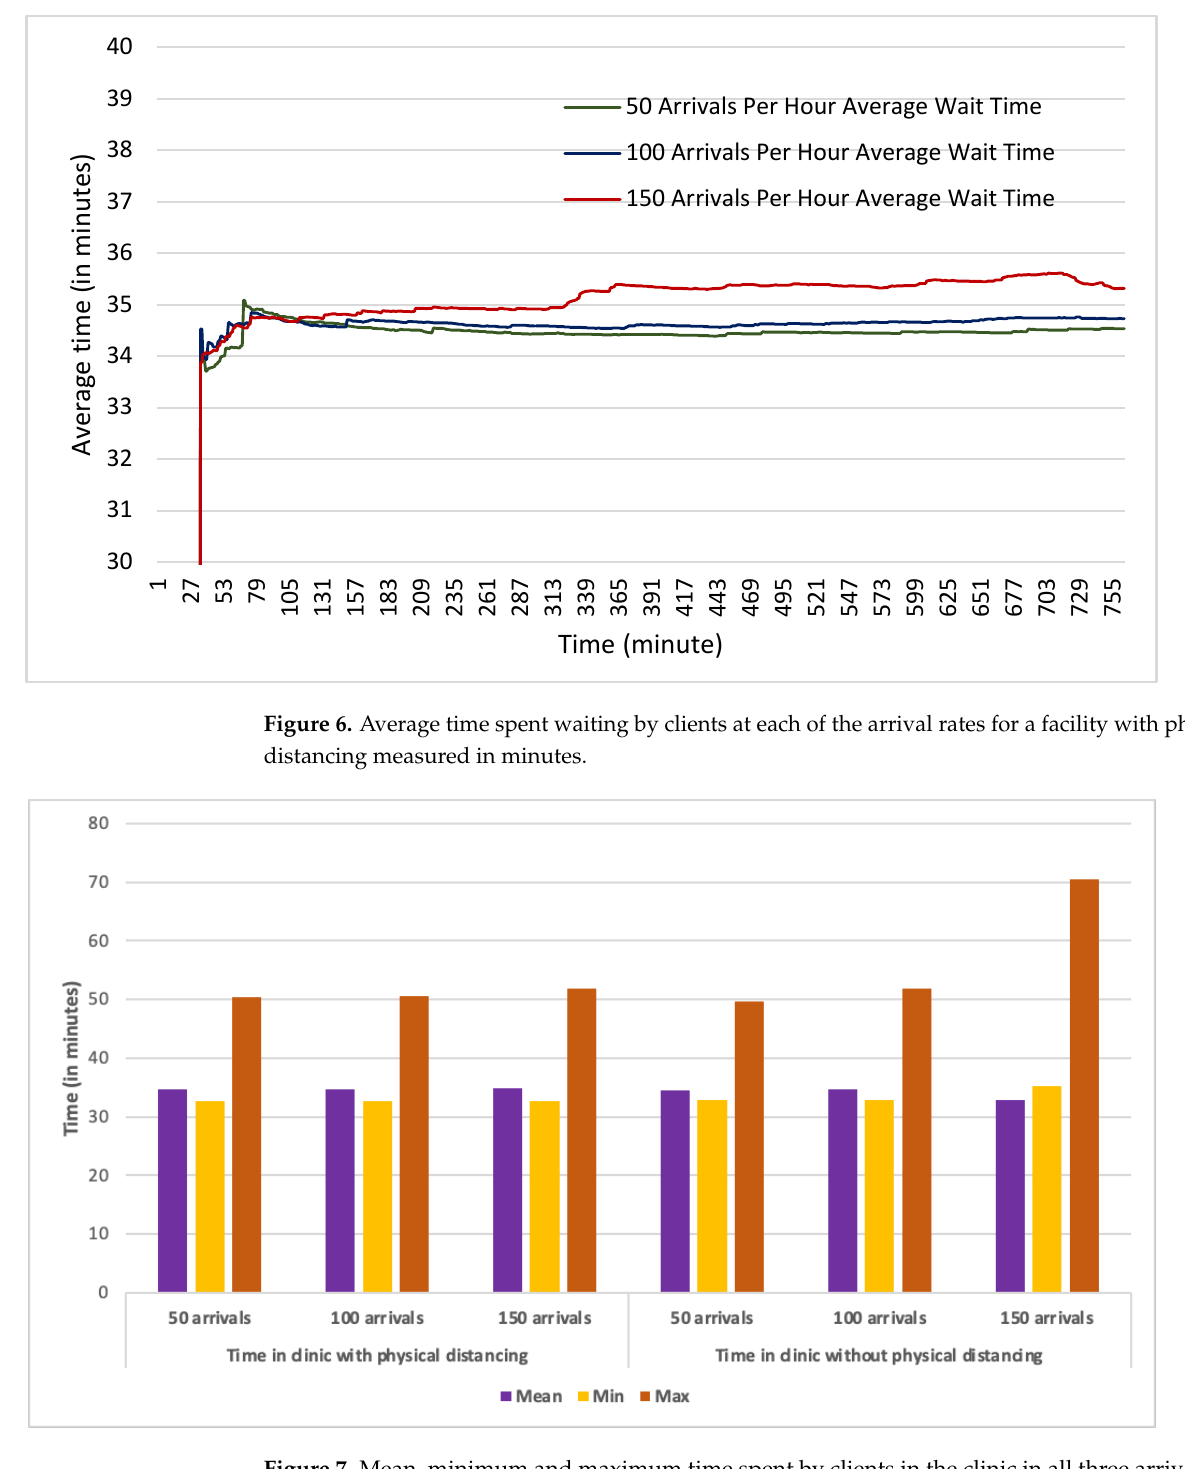
Figure 7. Mean, minimum and maximum time spent by clients in the clinic in all three arrival rate scenarios with and without physical distancing represented in minutes.